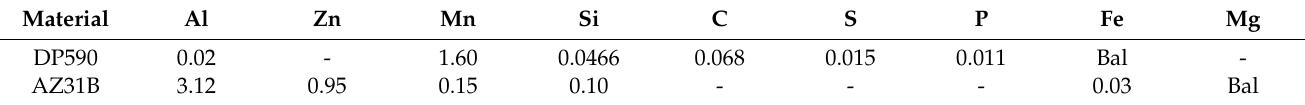
Table 1. Composition of welding base material (wt. %).